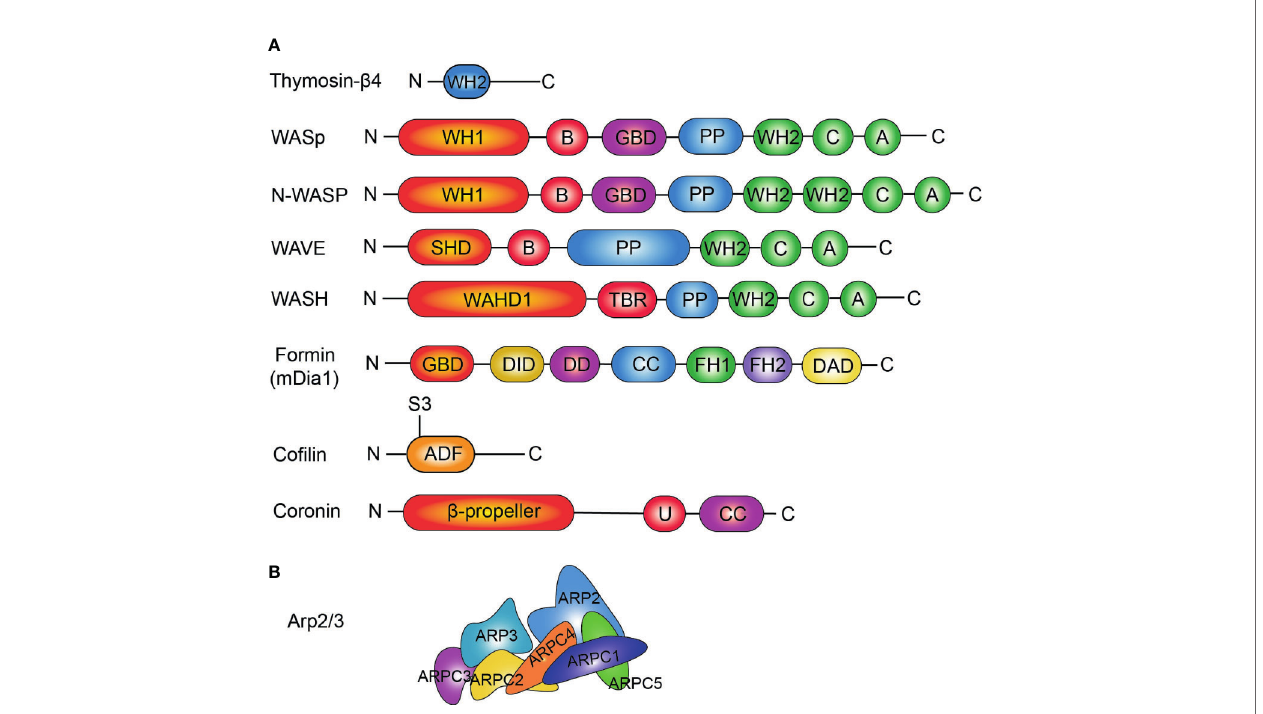
FIGURE 1 | (A) Domain structures of actin regulators important for lymphocytes. THY, thymosin b actin-binding motif; WH1, WASP Homology domain-1; B, Basic domain; GBD, GTPase binding domain; PP, poly-proline; WH2, WASP Homology domain-2; C, Connecting sequence; A, Acidic sequence; SHD, SCAR-homology domain; WAHD1, WASH Homology domain; TBR, Tubulin binding region; HD, Helical domain; DID, diaphanous autoregulatory domain; DD, dimerization domain; CC, coiled coil region; FH1, formin homology domain 1; FH2, formin homology domain 2; DAD, diaphanous autoregulatory domain; ADF, actin depolymerizing factor; U, unique region; CC, coiled-coil. (B) Conformation of Arp2/3 complex. ARP2; ARP3; and ARP complex-1~5 (ARPC1~5) are